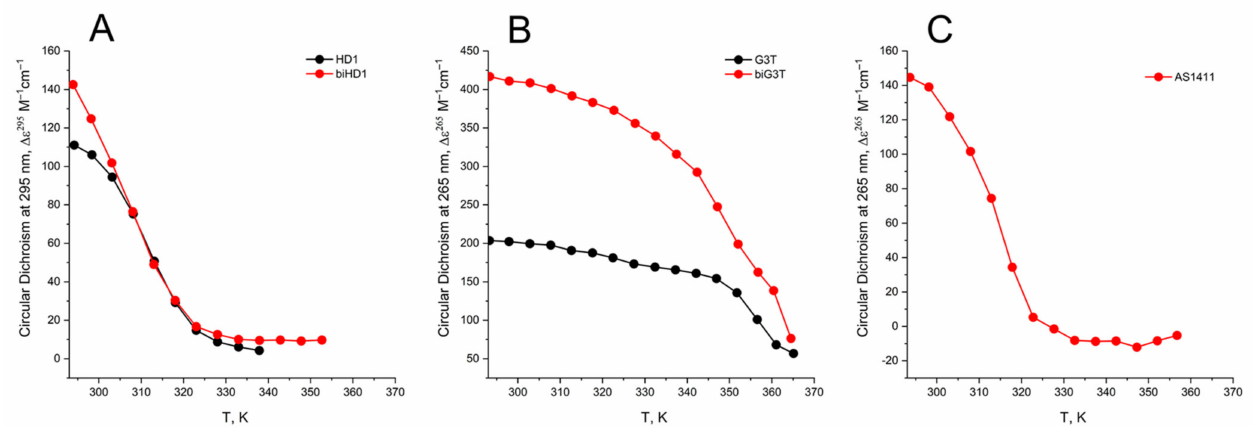
Figure 5. CD melting profile of GQs under study in buffer B (140 mM NaCl and 10 mM KCl): ( A ) HD1 (black), bi-HD1 (red); ( B ) AID-1-T (black), bi-(AID-1-T) (red); ( C ) AS1411 (red). Temperature is in kelvin (K): [ ◦ C] = [K] −